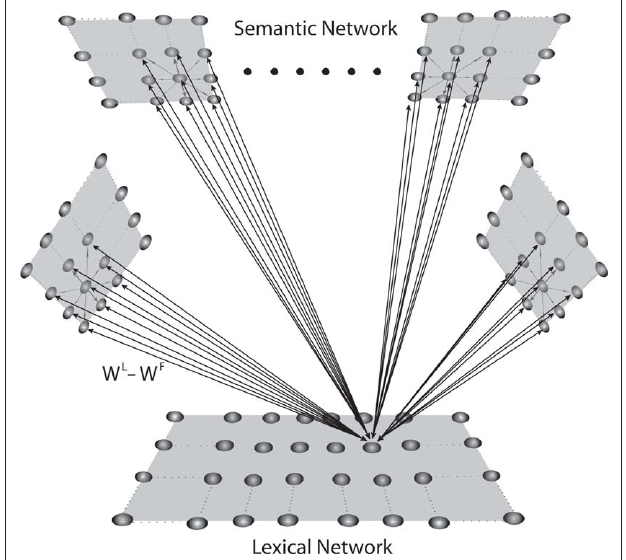
Figure 1 | Schematic diagram describing the general structure of the network. The model presents a “semantic network” and a “lexical network.” The semantic network consists of nine distinct Feature Areas (upper shadow squares), each composed of 20 × 20 neural oscillators. Each oscillator is connected with other oscillators in the same area via lateral excitatory and inhibitory intra-area synapses, and with oscillators in different areas via excitatory inter-area synapses. The lexical area consists of 20 × 20 elements (lower shadow square), whose activity is described via a sigmoidal relationship. Moreover, elements of the feature and lexical networks are linked via recurrent synapses ( W F , W L